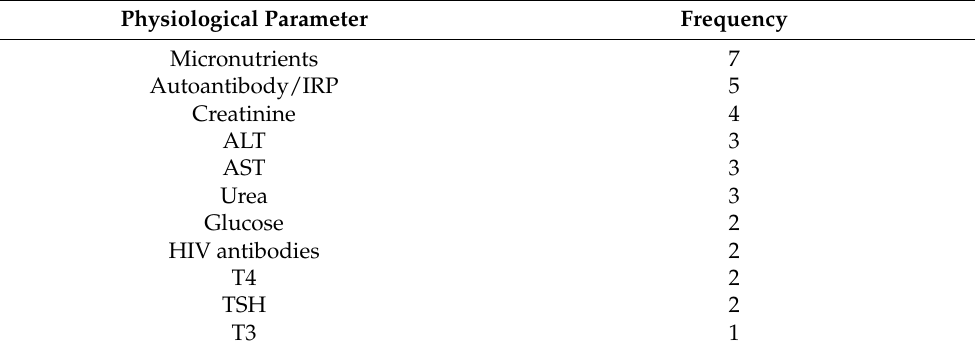
Table A5. Physiologic parameters assessed in serum samples in eight studies. Physiological Parameter